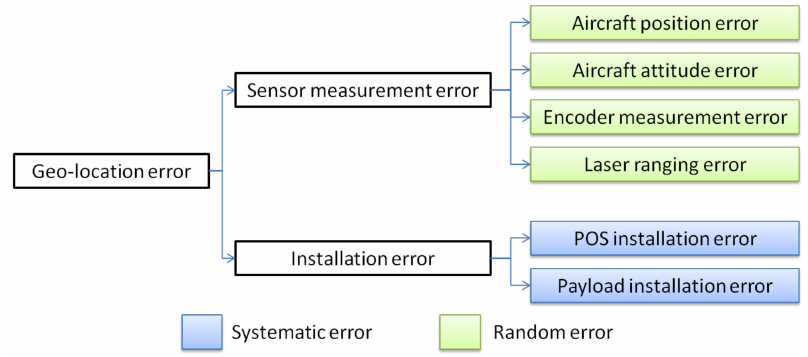
Figure 6. Error items that affect the accuracy of target